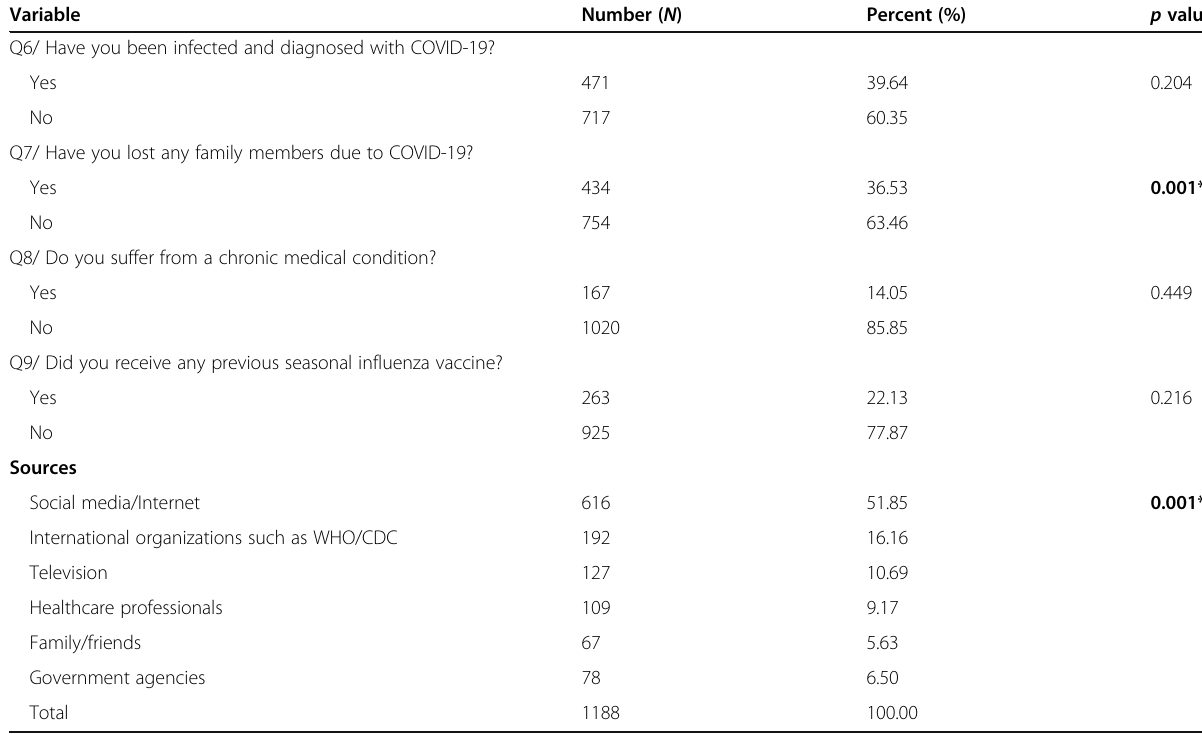
Table 2 Relevant responses to the COVID-19 vaccine